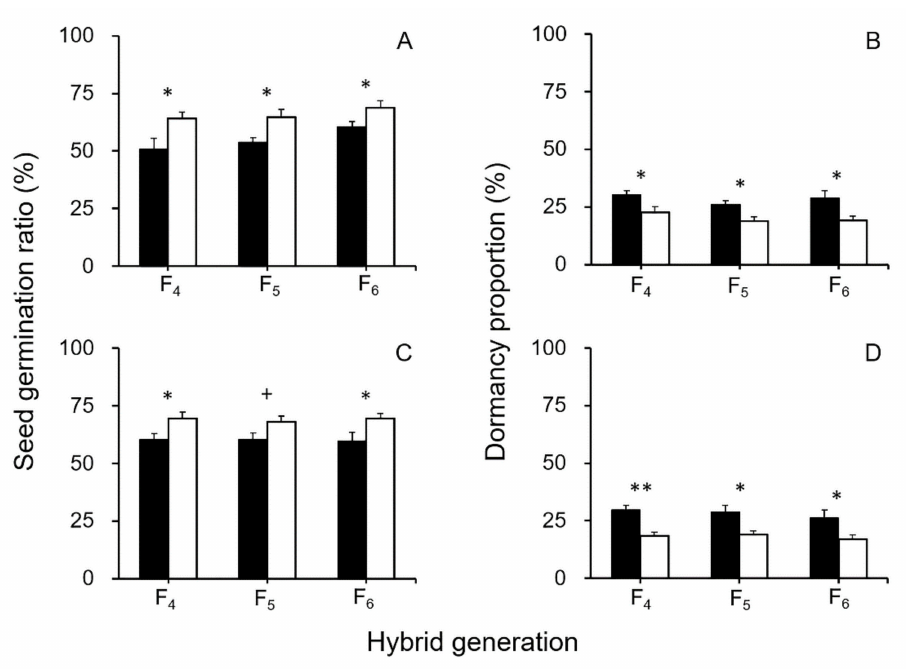
Figure 5. Average seed germination and dormancy ratios of the crop (EP3)–wild rice (w1 or w2) hybrid seeds (F 4 –F 6 ). All seeds were not treated both with dormancy breaking and soil burial. ( A , C ) seed germination ratios of EP3–w1 and EP3–w2; ( B , D ) seed dormancy ratios of EP3–w1 and EP3–w2. Comparisons were made between GE (black columns) and non-GE (white columns) seeds based on the independent- sample Student’s t -test. Bars represent standard error ( n = 6 replicates). + p < 0.1, * p < 0.05, ** p <